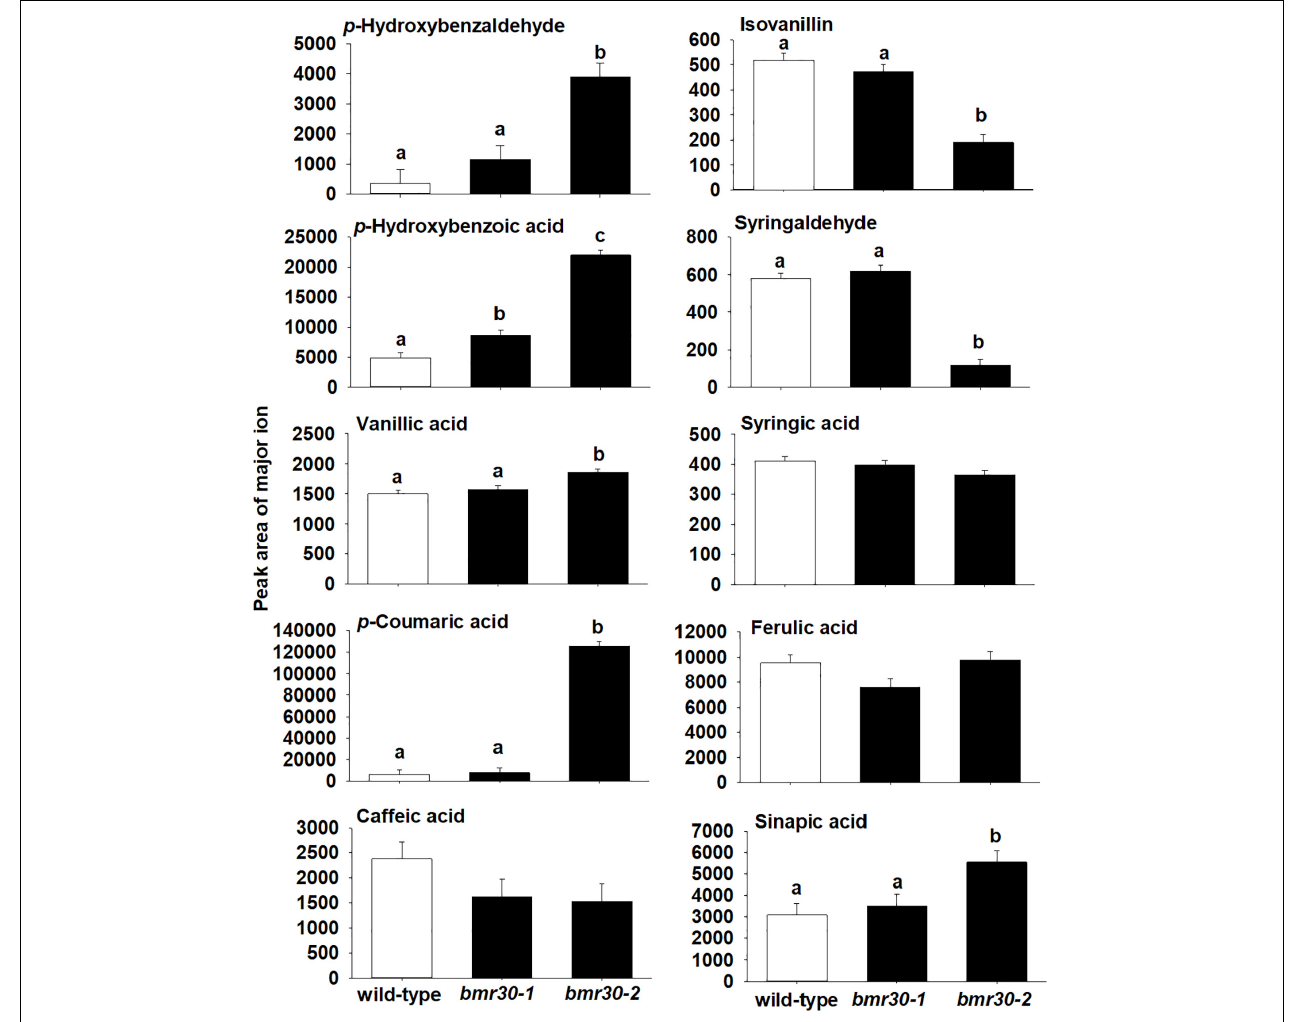
FIGURE 7 | Relative abundance of soluble phenolic compounds in stover from wild-type, bmr30-1 , and bmr30-2 plants. Phenolic compounds were analyzed via GC–MS. Values presented are least square means; error bars represent standard error. Samples with different letters for soluble fractions are statistically different from one another at α ≤ 0.05 using Tukey’s HSD